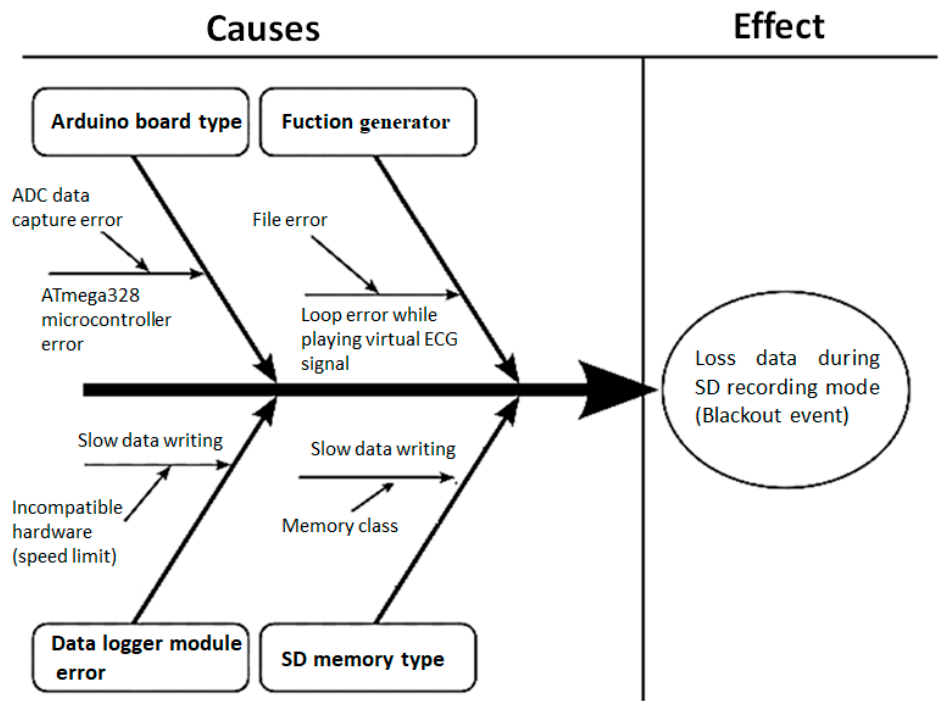
Figure 10. Ishikawa diagram to identify causes of the problem. Identified problem: loss of information with the occurrence of blackout events during writing to microSD. Possible causes: Arduino type, function generator, error by data logger module, or SD card memory type.